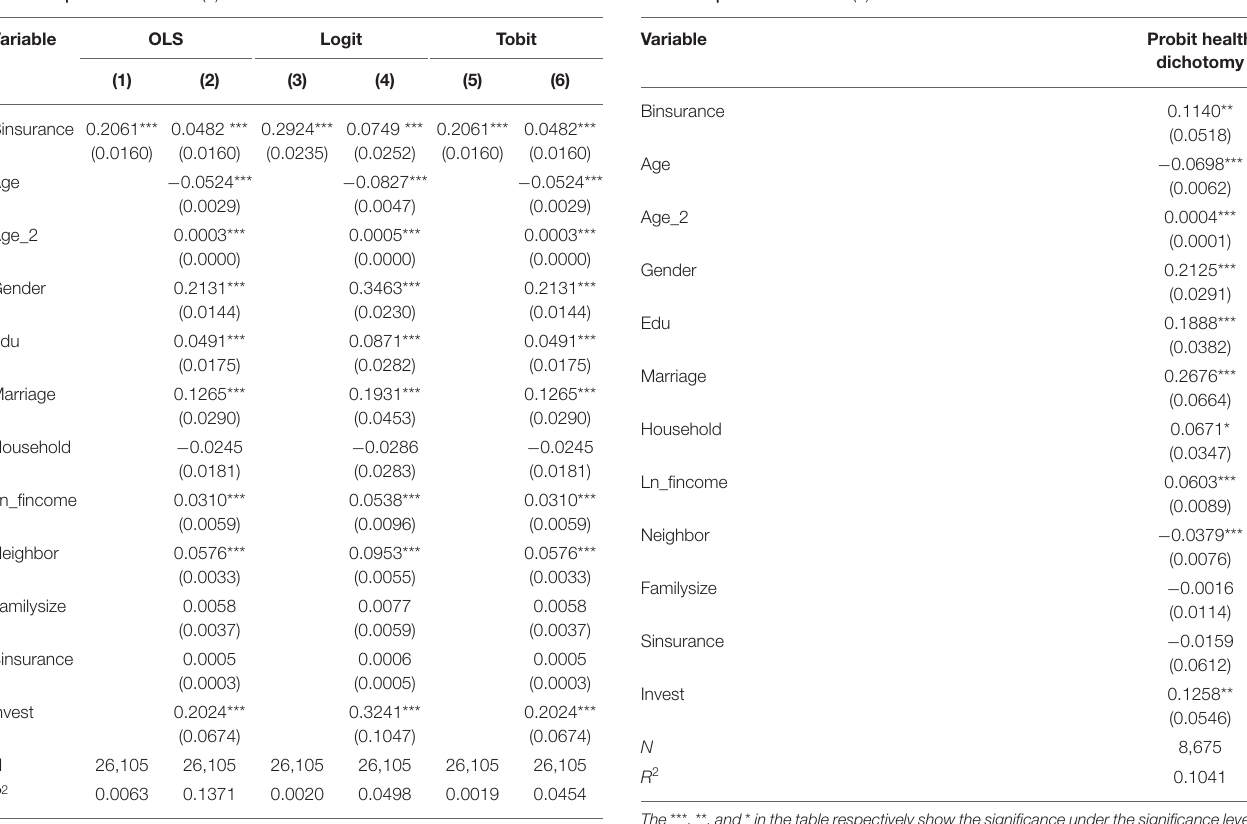
TABLE 4 | Robustness test (1). TABLE 5 | Robustness test